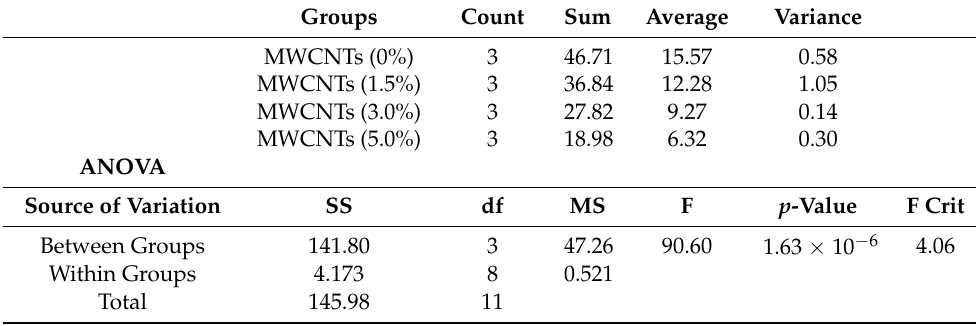
Table 7. Formaldehyde emission values of MWCNTs-UF MDF for numerous iterations.